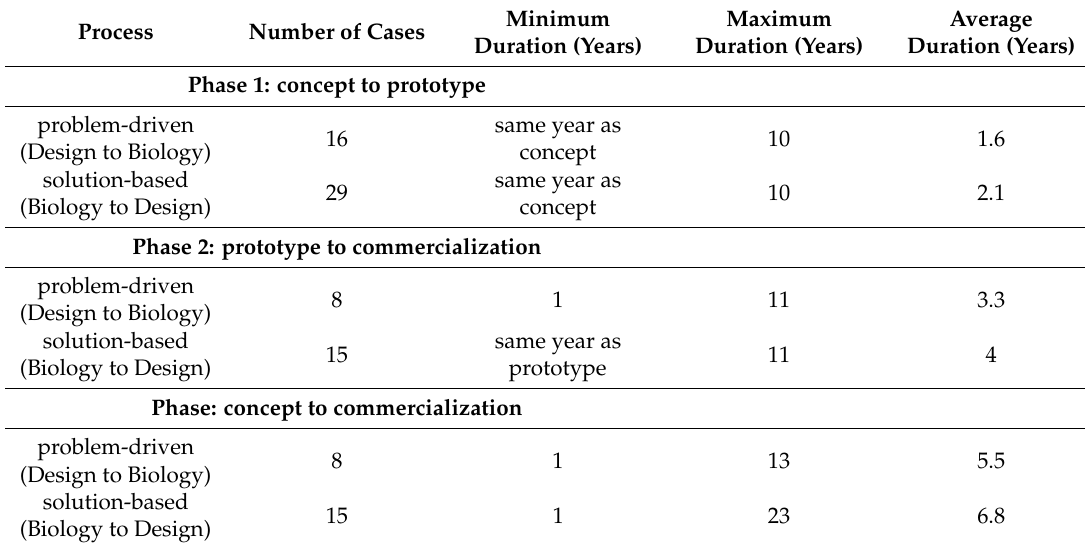
Table 2. Time to develop prototypes and products for commercialization, based on the two approaches of